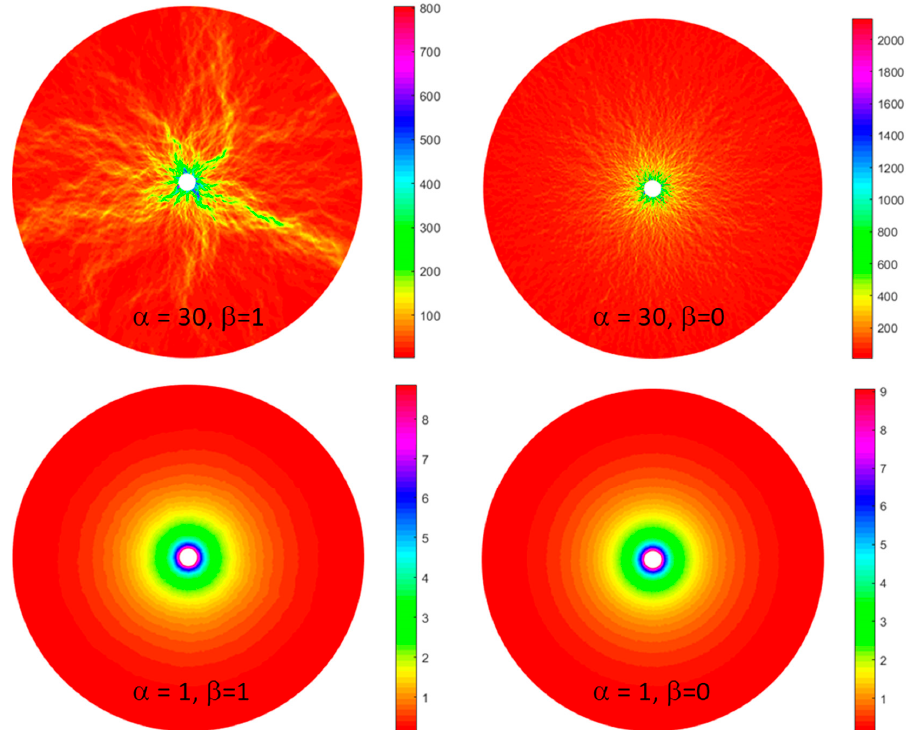
Figure 9. Flow calculated from a central well to free-flow boundaries where it escapes the system for different values of α in Equations (2) and (3) and β in Equation (4). Color indicates the relative magnitude of the fluid velocity (red low, purple high). Flow channeling ( upper left panel ) requires that both a large spread in ln κ from its mean (e.g., α = 30) and a distribution in permeability that is pink ( β = 1). The variation in the magnitude of permeability from its mean can be large, but cannot produce channel flow if its spatial variation is that of spatially uncorrelated white noise ( top right panel ). The permeability distribution can be 1/k (pink noise) but cannot produce channel flow unless the variation in ln permeability is also large ( bottom left panel ). When the permeability distribution is white and the spread in ln permeability small, the flow from the well is of course uniform ( bottom right panel ).